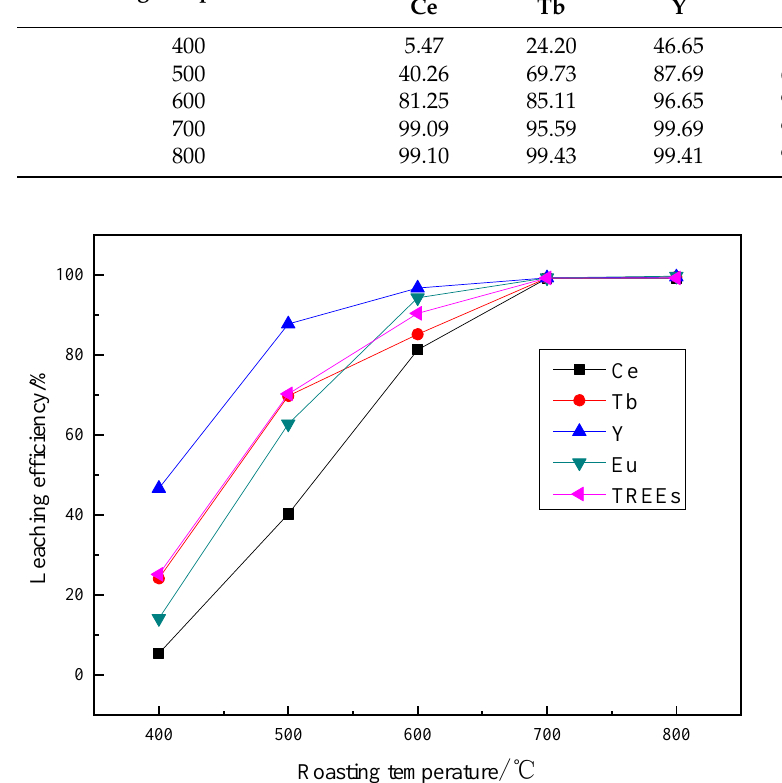
Figure 7. Influence of the roasting temperature on the REEs leaching efficiencies (oxygen concentra- tion in the mixed gas of 0.4%, roasting time of 3 h, mass ratio of phosphor powder to alkali 1:3, HCl solution concentration of 8 mol·L −1 , acid leaching temperature of 60 °C, acid leaching time of 1 h, and liquid–solid ratio of 10:1.).